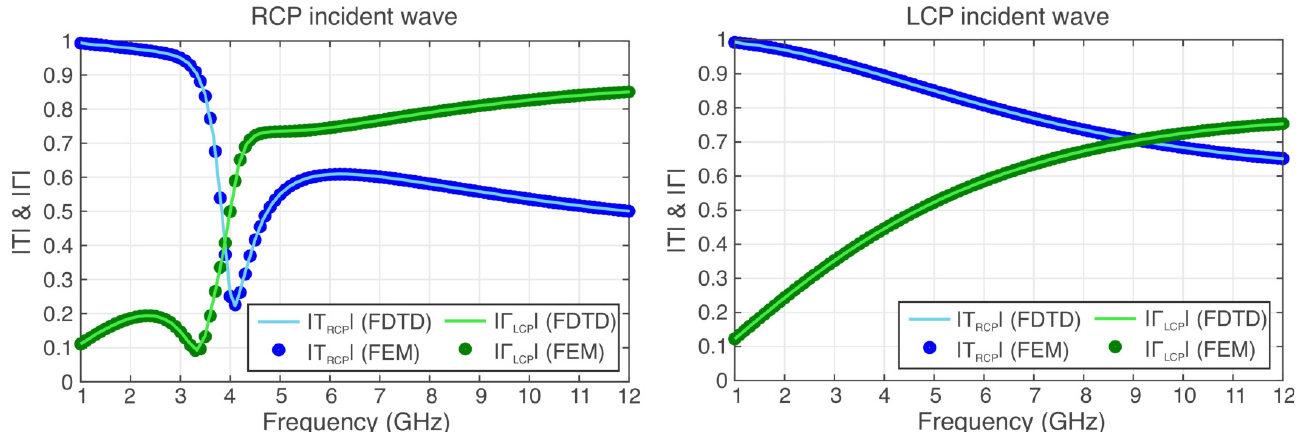
Figure 3. The reflection and transmission coefficients for the RCP and LCP